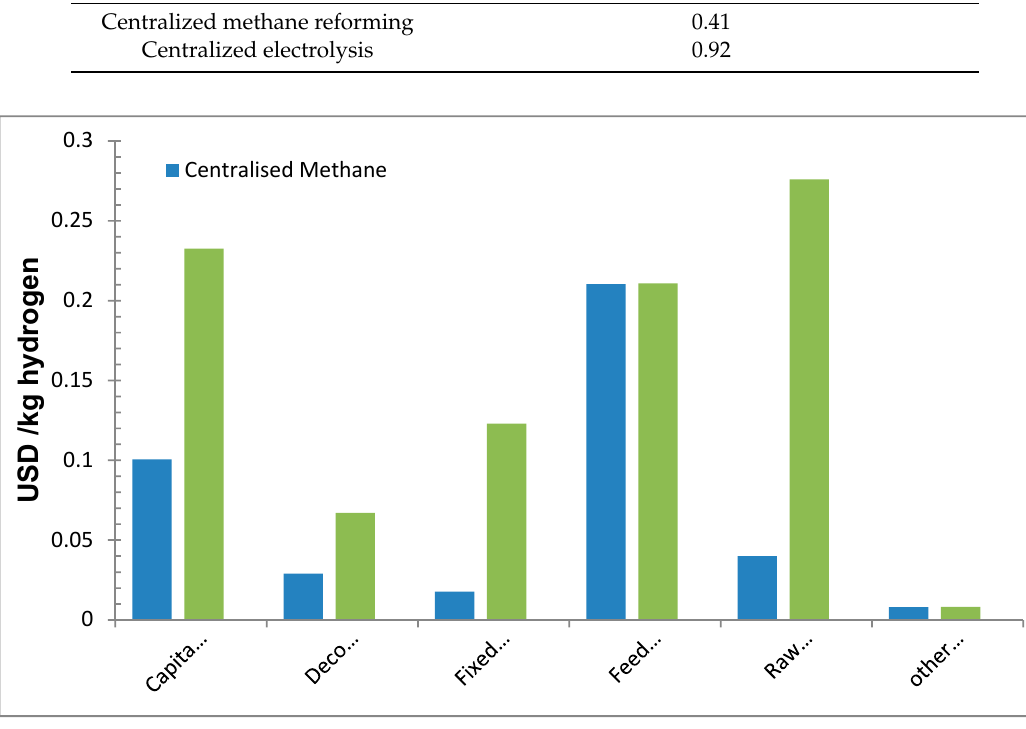
Figure 7. Hydrogen cost contribution for hydrogen transportation and dispensing life cycle.